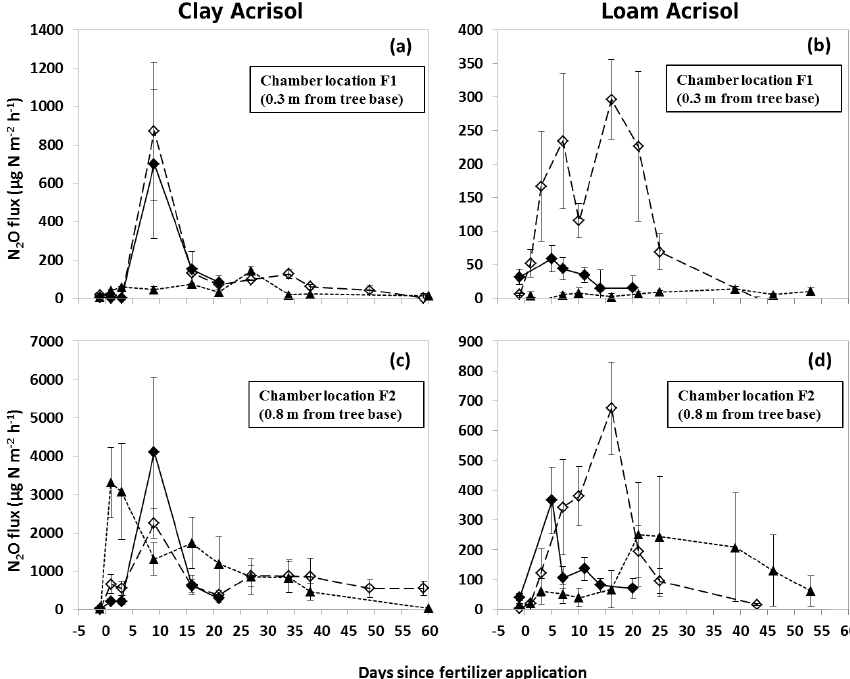
Figure 2. Mean ( ± SE, n = 3 oil palm trees) soil N 2 O fluxes during a fertilization in smallholder oil palm plantations 1 ( (cid:7) ), 2 ( (cid:5) ) and 3 ( (cid:78) ) in the clay (a, c) and loam Acrisol (b, d) landscapes. Smallholders fertilized around the base of each tree at about 0.8–1m from the tree base. Fluxes were measured at F1 = 0.3m from the tree base (a, b) and at F2 = 0.8m from the tree base on the fertilized location (c, d) with 0.32kgNtree − 1 in the clay Acrisol and 0.26kgN tree − 1 in the loam Acrisol in accordance to the smallholders’